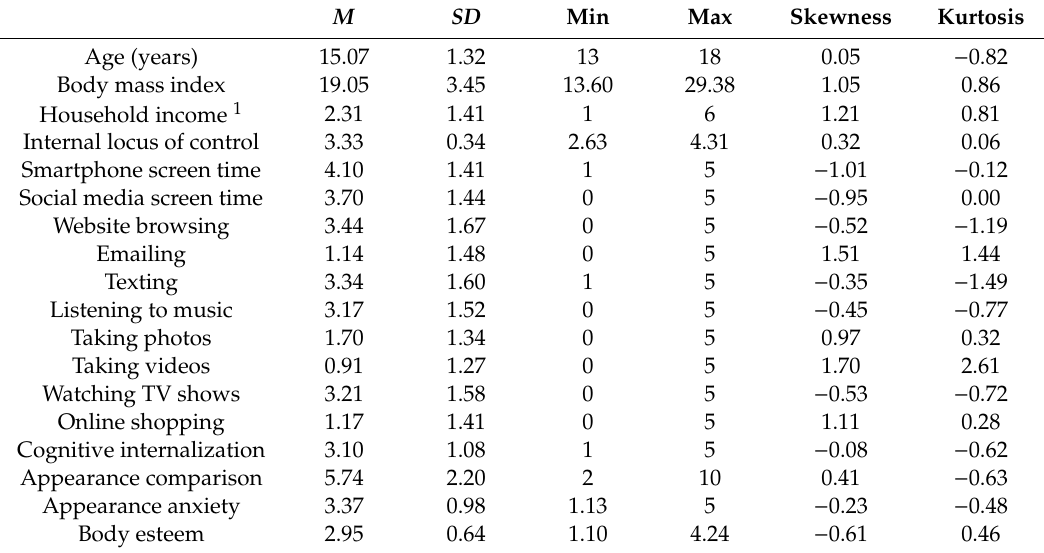
Table 1. Descriptive Statistics of